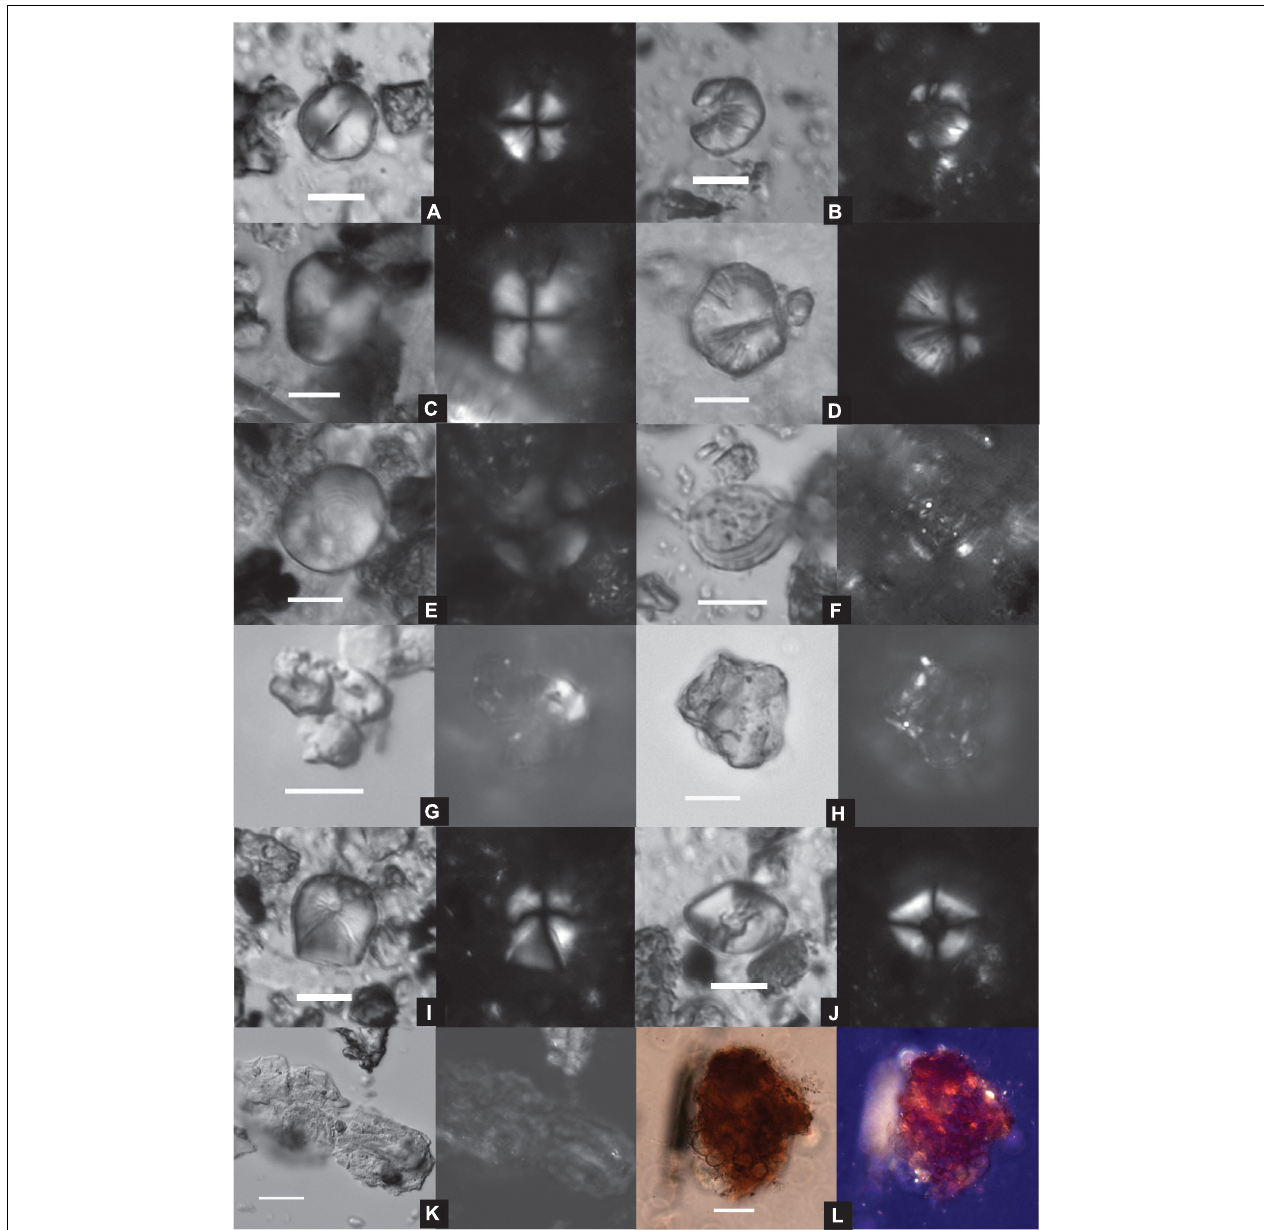
FIGURE 4 | Ancient starch granules from Erlitou pottery vessels (each starch image is shown in DIC and polarized views). (A) Paniceae; (B) damaged Paniceae with edge partially missing and deep fissures; (C) job’s tears; (D) damaged Job’s tears with pitting and deep fissures in bright field; (E) damaged Triticeae, blurry birefringence in polarized light; (F) damaged Triticeae with pitting, deep fissures, and concave center in bright field, birefringence only shown at the edge in polarized light; (G) damaged rice cluster, concave center in bright field and disappeared birefringence in polarized light; (H) damaged rice cluster, partially gelatinized, some showing complete granule shapes; (I) damaged snake gourd root with pitting; (J) damaged snake gourd root with disappeared center and deep fissures; (K) unidentified gelatinized starch; (L) starch cluster, dyed with Congo red (Scales, A–J : 10 µ m; K,L : 20 µ